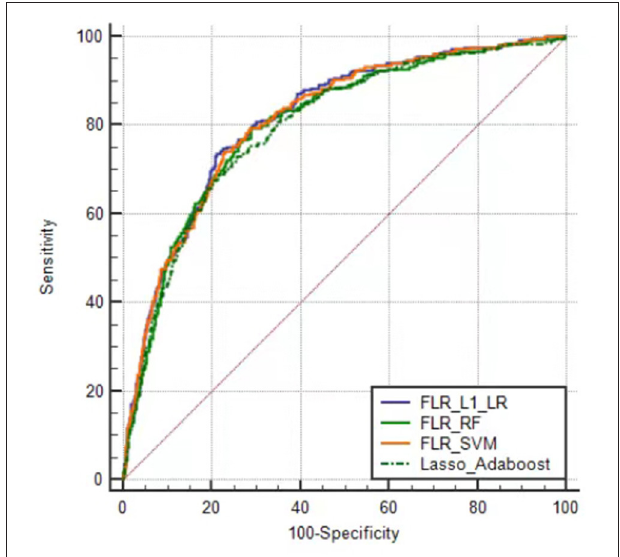
FIGURE 1 | Receiver operator characteristic curves of the optimal prediction model in Xinjiang rural population. FLR-L1-LR, L1 regularized Logistic regression with forwarding Partial Likelihood Estimation; FLR-RF, Random forest with forwarding Partial Likelihood Estimation; FLR-SVM, Support vector machine with forwarding Partial Likelihood